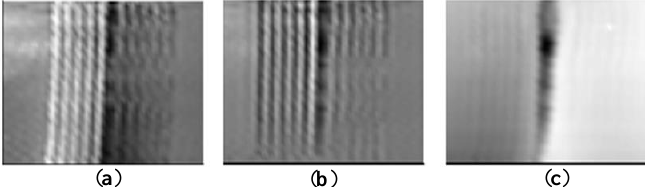
Figure 8. Original images of the portion of the covered crack under 30 × 30 scanning, obtained at three standoff distances: ( a ) 0.2 mm, ( b ) 0.8 mm, and ( c ) 1.7 mm.